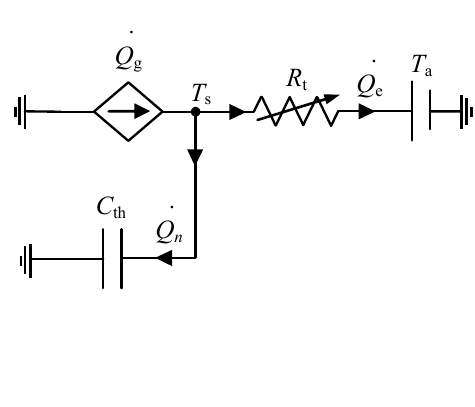
Figure 3. Thermal model of the